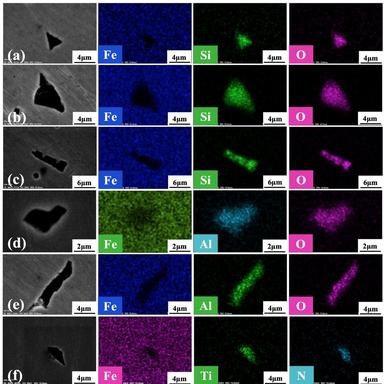
2D morphologies and types of the inclusions in Matrix, MZ and LMF (with or without ASMF) in this study, (a) (b) and (c) SiO2, (d) and (e) Al2O3, (f) TiN, respectively.